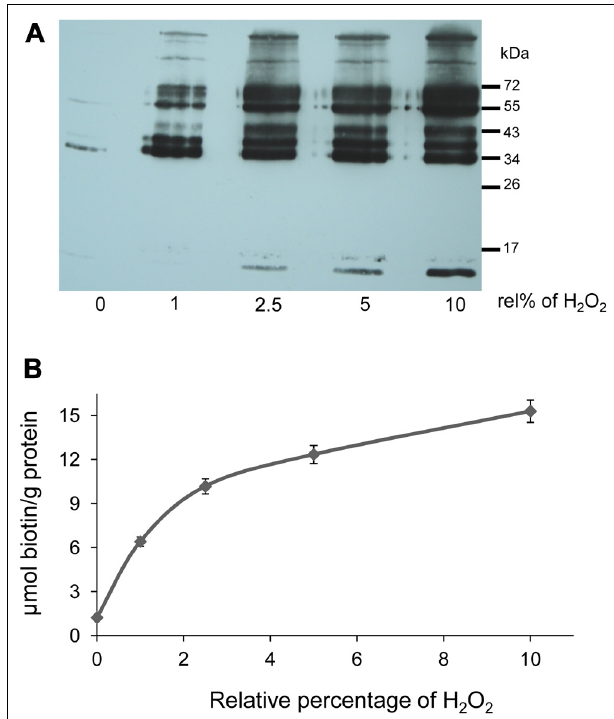
FIGURE 3 | H 2 O 2 -dependent oxidation of stroma proteins. (A) Western blot analysis with anti-biotin antibody to detect oxidized stroma proteins. “rel%” stands for the amount of H 2 O 2 added relative to the thiol contents of the protein sample (100%).The bands demonstrate H 2 O 2 -dependent oxidation of stroma proteins. Same samples were used for biotin quantification.The experiment with similar results was performed three times. (B) Degree of biotinylation in H 2 O 2 -treated samples as calculated from HABA displacement assay. For biotin quantification, 10 μ g of proteins were used. Data are means ± SD, n =